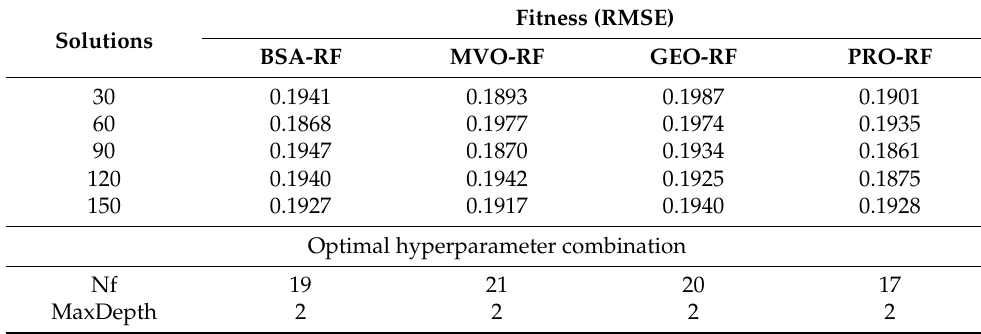
Table 2. Development results of all hybrid RF models.